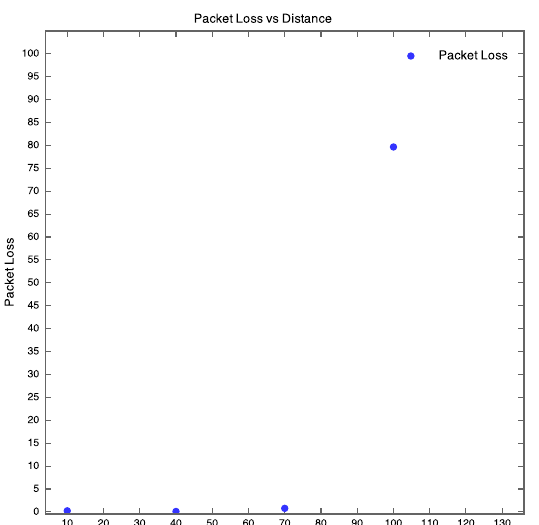
Figure 5. Packet loss vs Distance for Experiment